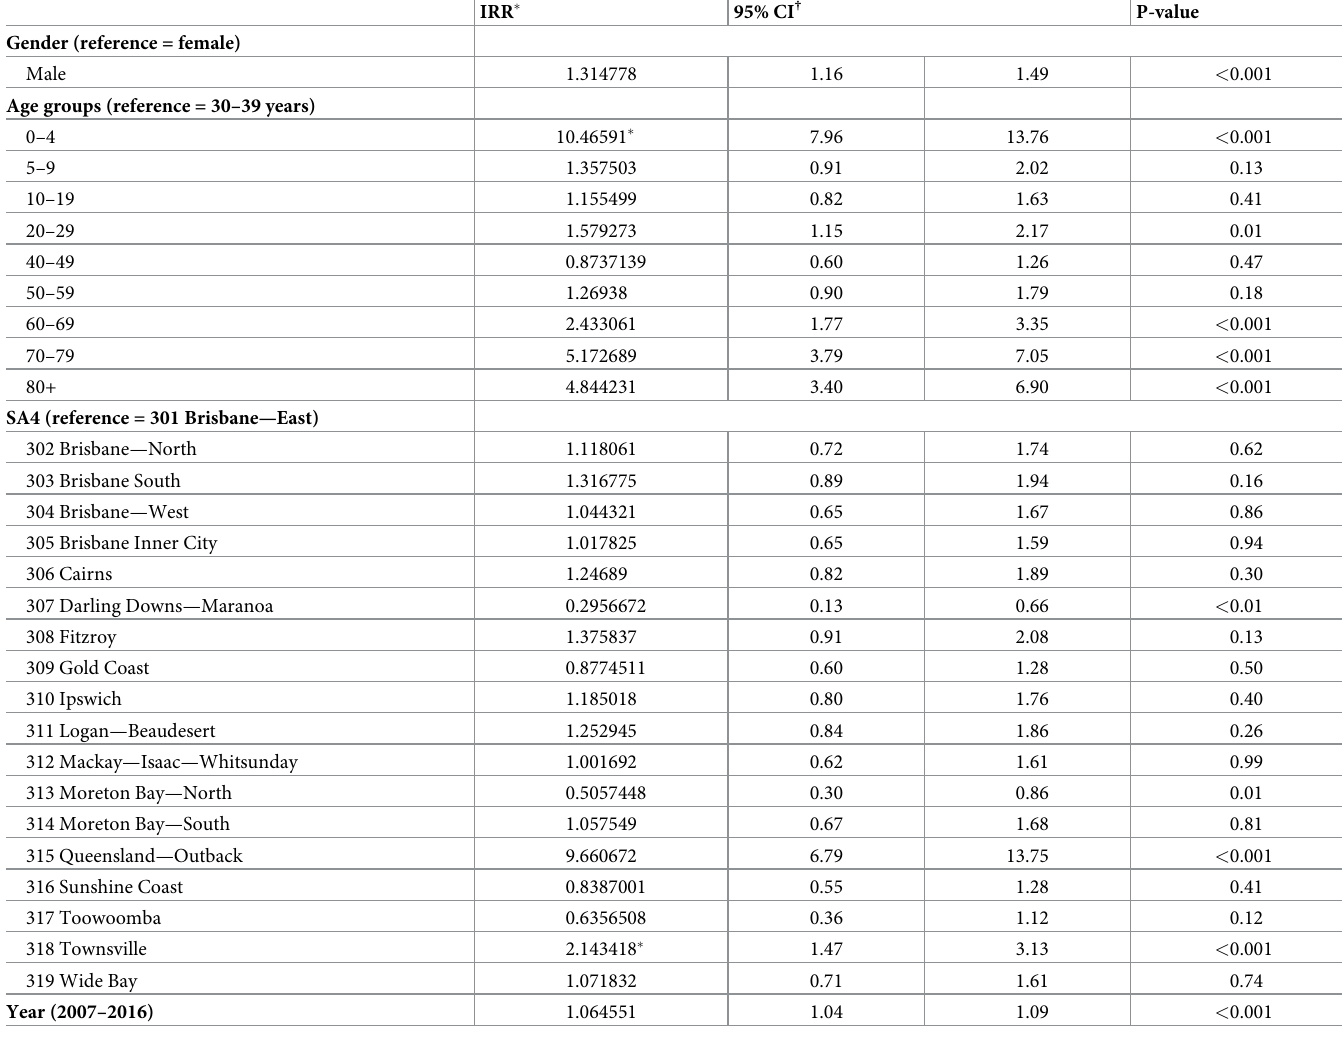
Table 2. Adjusted incidence rate ratios calculated using Poisson regression of iNTS disease in Queensland by sex, age, location, and year, 2007–2016.